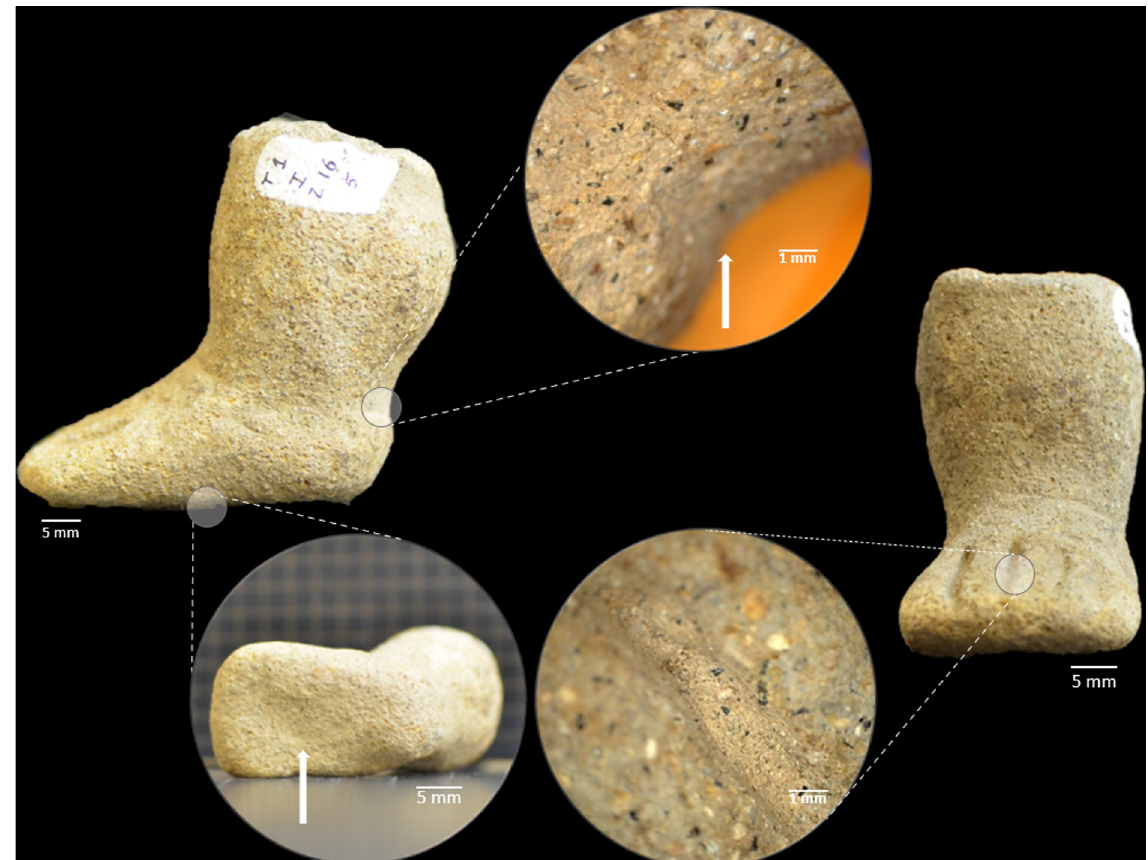
Fig 9. Evidence of direct modeling on clay. IN01 fragment showing traces of direct modeling on the clay, manual pressure of the fingers to shape the ankle, pointed out with white arrows and, sole of the foot and incised decoration to represent the